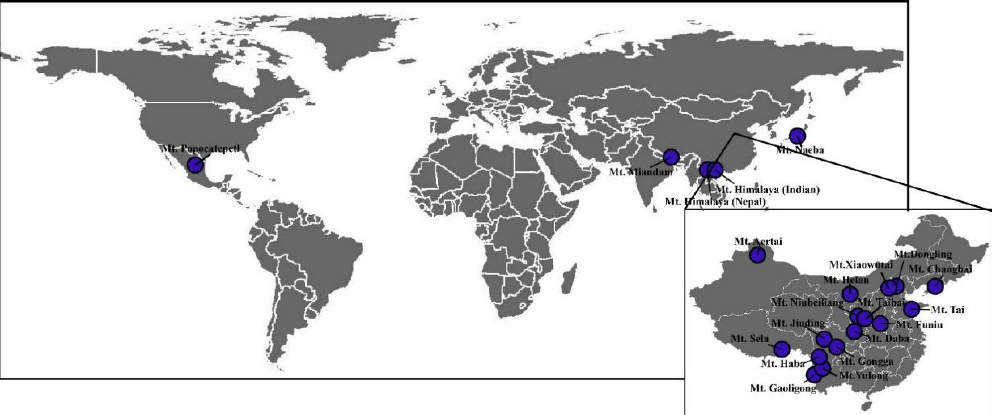
Figure 1. Map with locations of the 22 mountain areas included in this study.